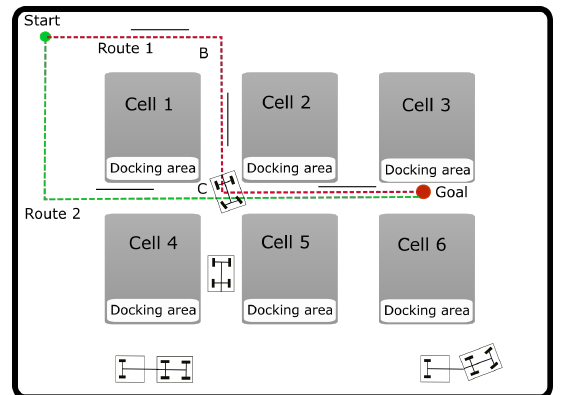
Figure 2. Tugger train working area. There is a dropping/pick-up point in each cell. Tugger trains can turn from the surrounding area into the corridors but once in a corridor they cannot turn ninety degrees into other